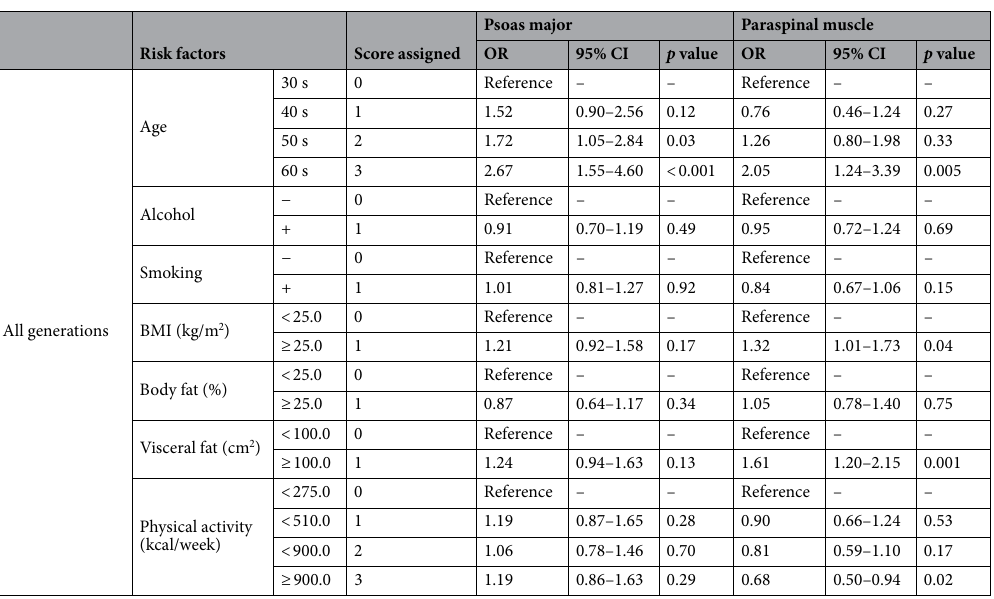
Table 2. Multivariate analysis for predicting changes in the psoas major and paraspinal muscle